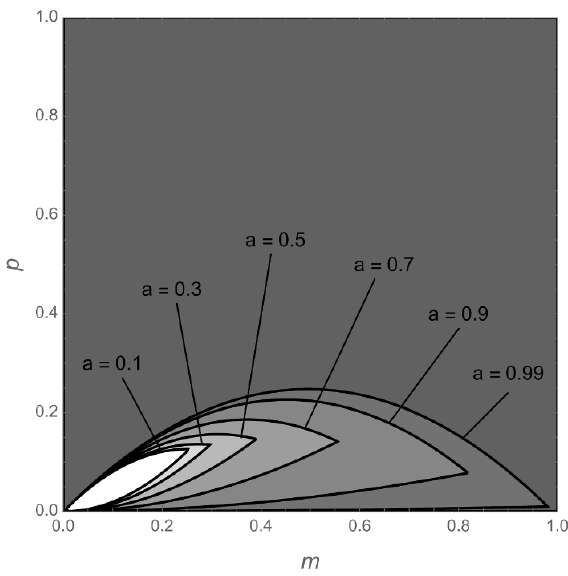
Figure 4 . The shaded areas (exterior to the almond shaped areas) indicate regions in the parameter space where the DEC is violated, for various values of the dilaton coupling 0 < a < 1. These regions are not optimal, in the sense that they were obtained as su(cid:14)cient but not necessary conditions for the DEC to be